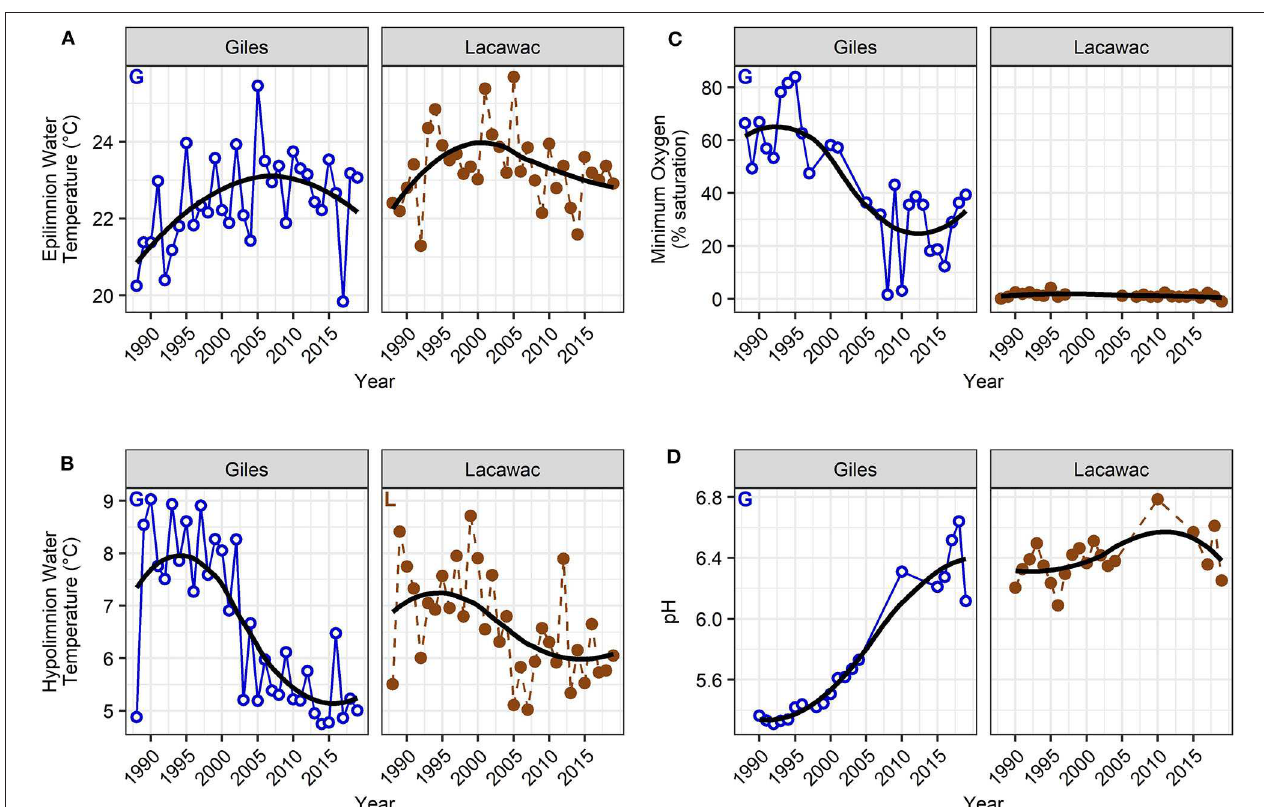
FIGURE 4 | Long-term summer average (June, July, August) changes in light-related habitat characteristics in Lake Giles (blue, open circles with solid line), and Lake Lacawac (brown, filled circles with dashed line). The strong change in PAR ( Figure 2 ) is the most likely factor leading to the warming epilimnion (A) , cooling hypolimnion (B) , and decrease in deep-water dissolved oxygen (C) ( Pilla et al., 2018). The increases in pH (D) , statistically significant only in Lake Giles, are most likely due to decreases in acid deposition in the region during the study period ( Williamson et al., 2015). Letters indicate statistically significant long-term trends in Giles (“G”) and in Lacawac (“L”; Mann-Kendall non-parametric trend test, p < 0.05). Black trend lines are LOESS smoothed